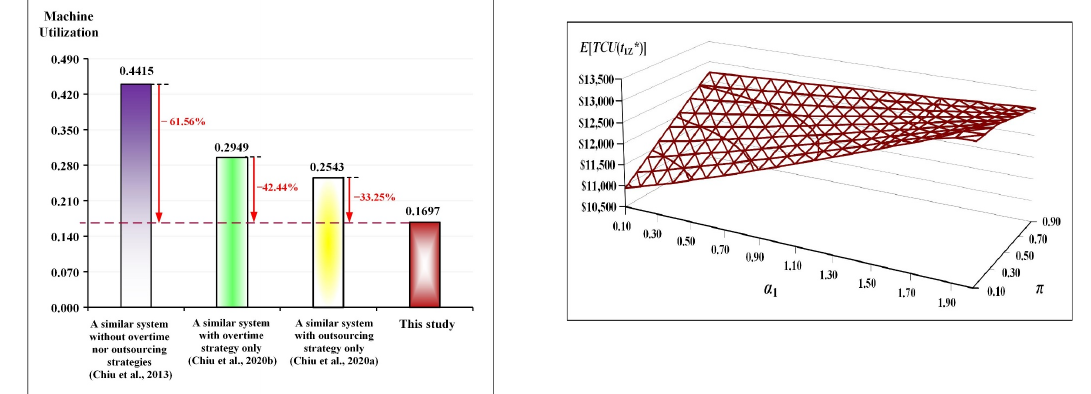
Fig. 16. The collect influence of α 1 and π on E [ TCU ( t 1Z *)]